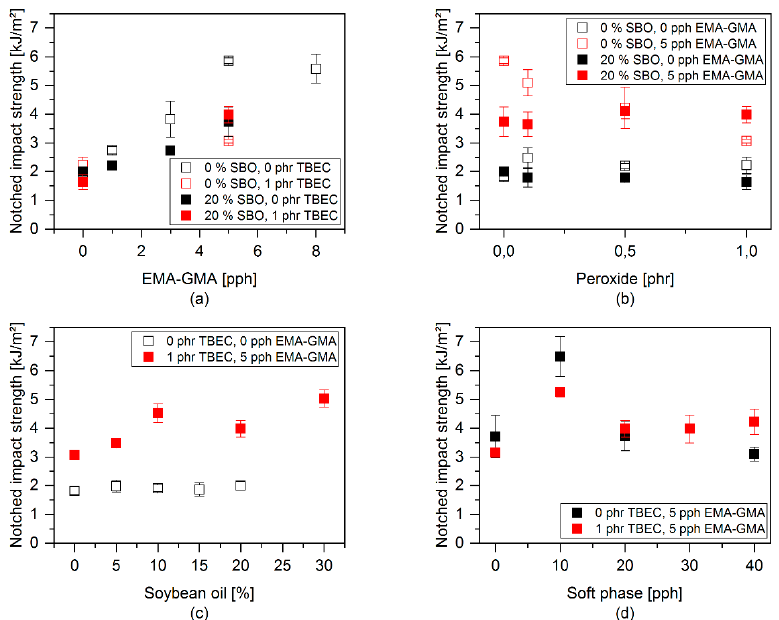
Figure 15. Notched impact properties with variation of different components: ( a ) Variation of EMAGMA content, ( b ) variation of TBEC content, ( c ) variation of SBO content, and ( d ) variation of soft phase content.